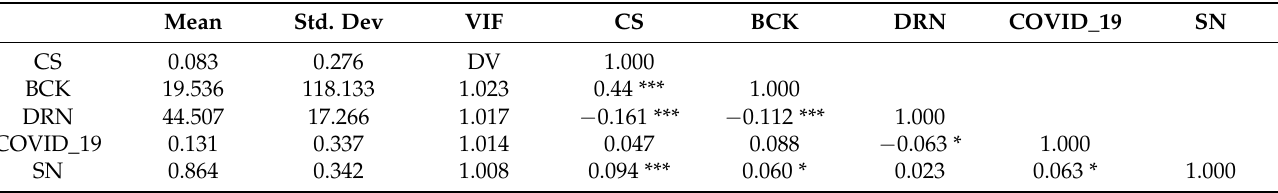
Table 6. Descriptive Statistics and Correlation Matrix.